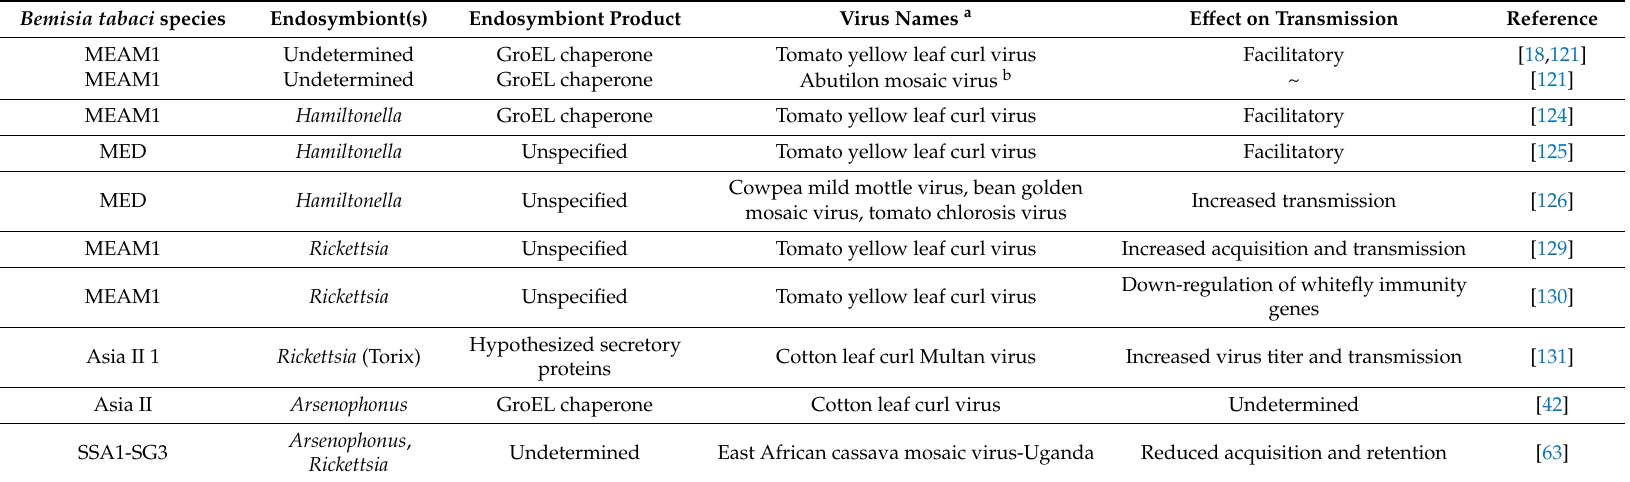
Table 2. Summary of the interactions of Bemisia tabaci endosymbionts with plant viruses demonstrated by in vitro or in vivo